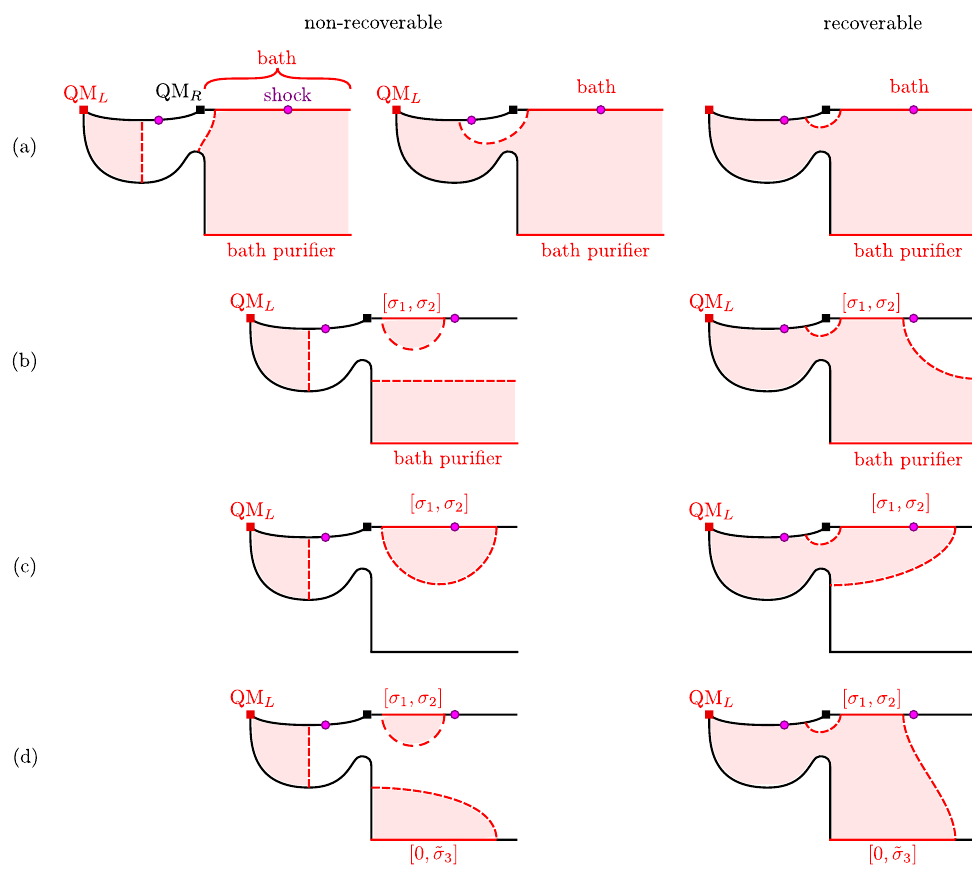
Figure 4 . Competing channels computing the generalized entropy of various subsystems (solid red) and the corresponding bulk RT surfaces (dashed red) and entanglement wedges (light red). In each case, the R-channel where the black hole interior is recoverable or reconstructable is shown on the left. On the right, we show the N-channel where the interior is non-recoverable or non- reconstructable. The corresponding generalized entropies for these channels are denoted S S , respectively. In the top row (a), we consider the generalized entropy of QM N and the bath’s purifier. In row (b), we keep only a finite interval [ σ 1 , σ 2 ] of the bath. In row (c), we further trace out the purifier. Finally, in row (d), we include a finite interval [0 , ˜ σ 3 ] of the purifier. Note that in this last case, we can also vary ˜ u 3 , the time slice of the purifier interval, and we find the minimal ˜ σ 3 depends on ˜ u 3 — see section